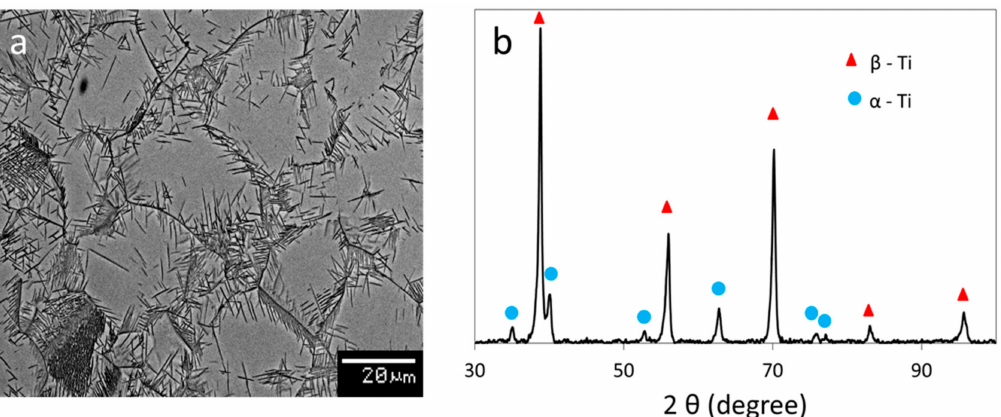
Figure 1. Scanning electron microscopy (SEM) image ( a ) and X-ray diffraction (XRD) spectrum ( b ) from the solution treated and aged workpiece